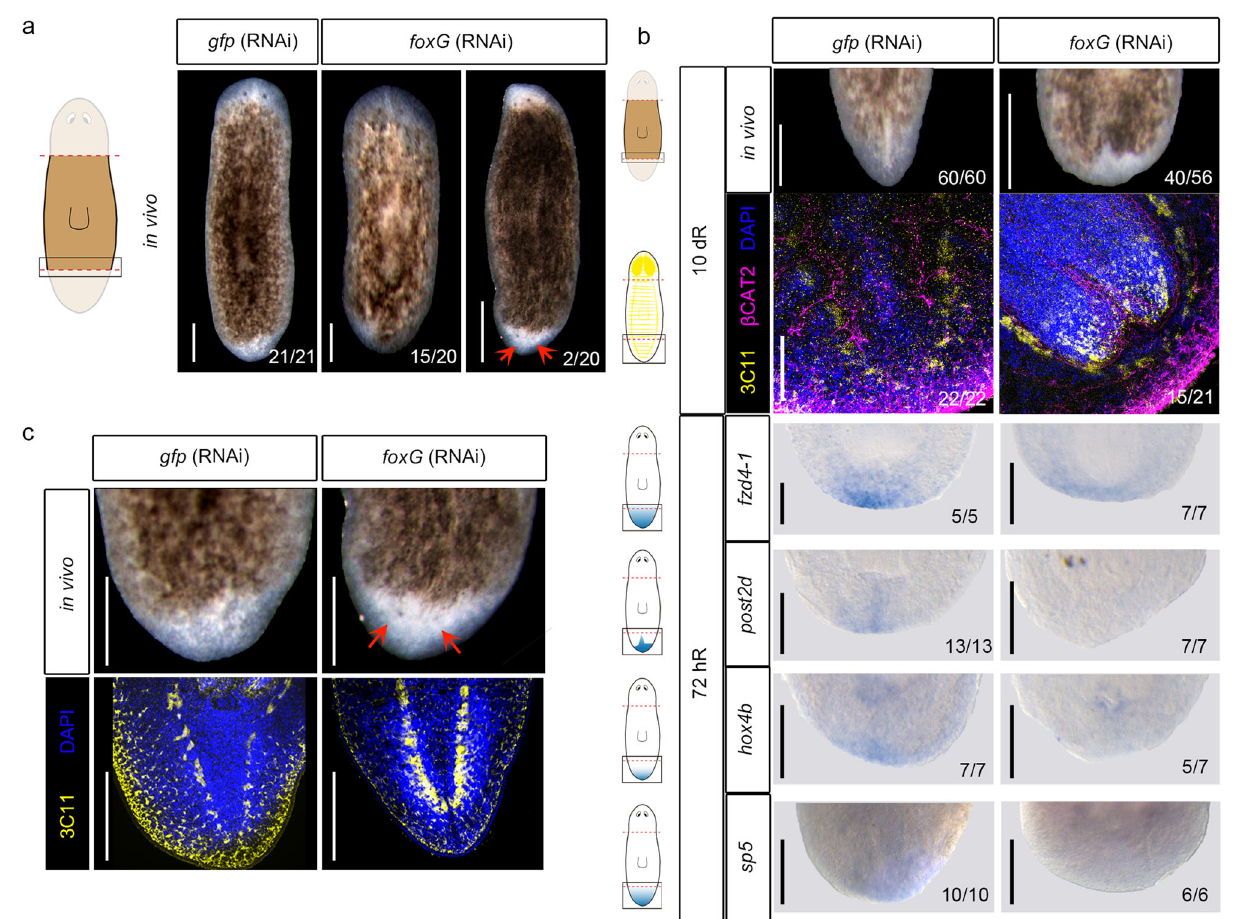
Fig. 5| foxG (RNAi)phenocopies wnt1 inhibition.a In vivophenotypesafter foxG (RNAi). Data representative of two independent experiments. b Immunostaining using α -SYNAPSIN (3C11) (neural system) and α - β CAT2 ( β -catenin-2, digestive sys- tem) reveals rounded ventral nerve cords in foxG (RNAi) (tailless phenotype). Nuclei are stained in DAPI. WISH of posterior markers in regenerating foxG (RNAi) animals demonstrated a reduced expression. Data representative of two